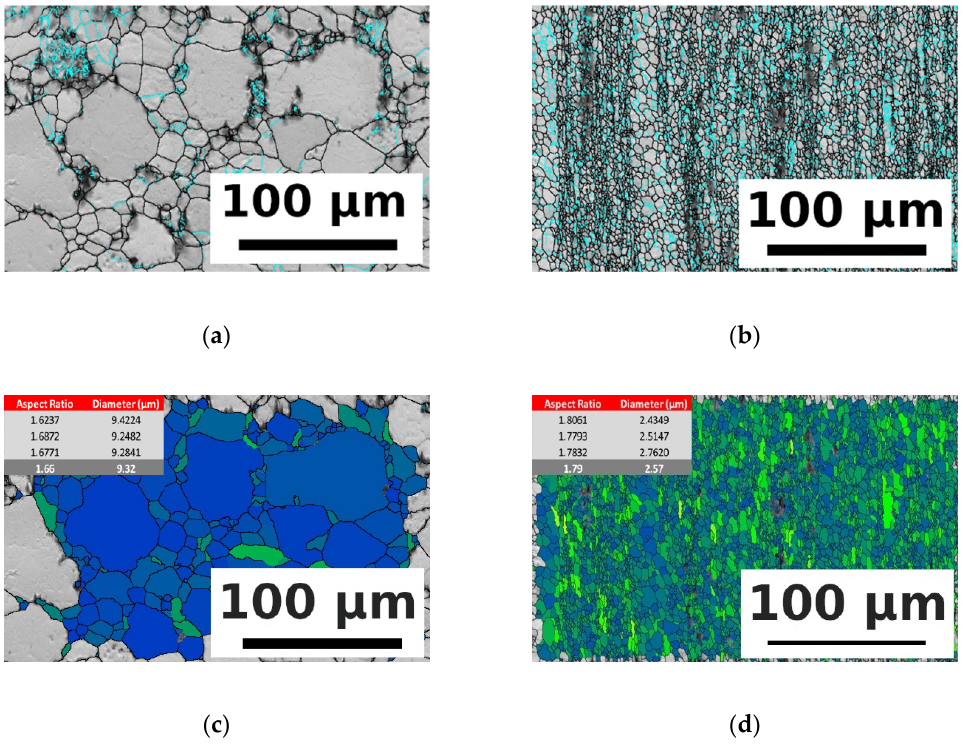
Figure 5. Maps of boundaries superimposed to image quality (IQ) images ( a , b ); grain size maps ( c , d ) of SPSed ( a , c ) and SPS-KOBO extruded ( b , d ) AA7075.